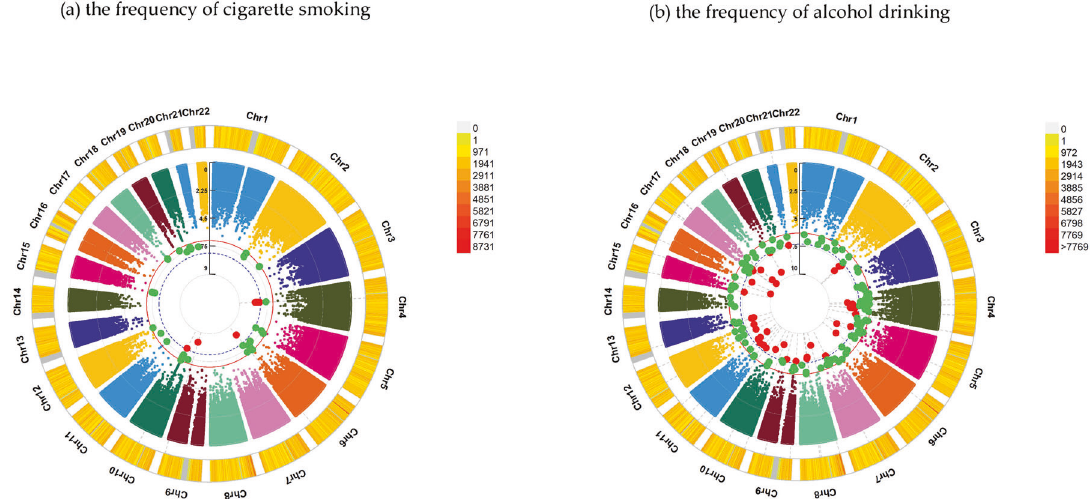
Fig. 2 Chromosomal regions interacting with felt hated by family member as a child for substance use. *From the center, the circos depicts the − log 10 P values of each variant. Red plots represent the P value < 5 × 10 − 8 and green plots represent P value < 5 × 10 − 7 . The plots were generated using the “ CMplot ” R script